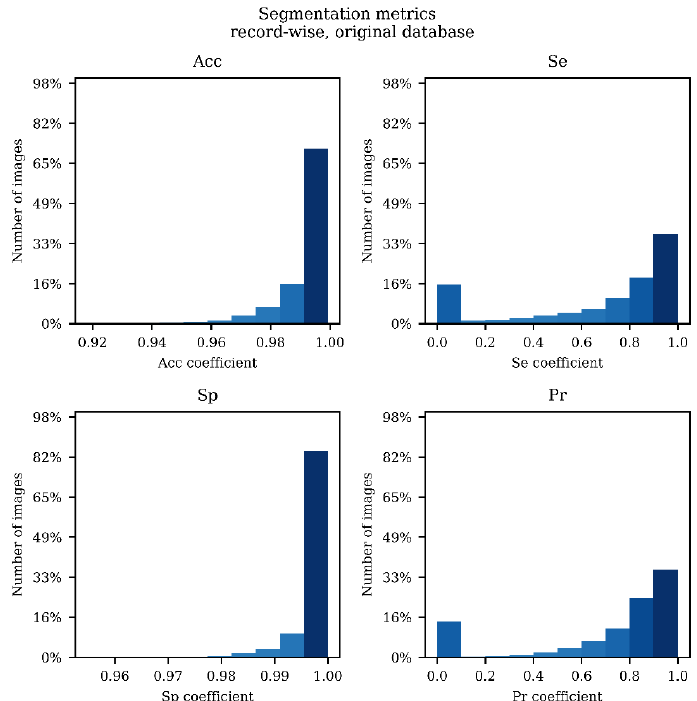
Figure A2. Histograms of metrics for segmentation results on a test set for a network trained on the on the original database with 5 -fold record-wise cross-validation. Acc —accuracy; Se —sensitivity; original database with 5 -fold record-wise cross-validation. Acc — accuracy; Se — sensitivity; Sp — Sp —specificity; Pr —precision. specificity; Pr — precision.